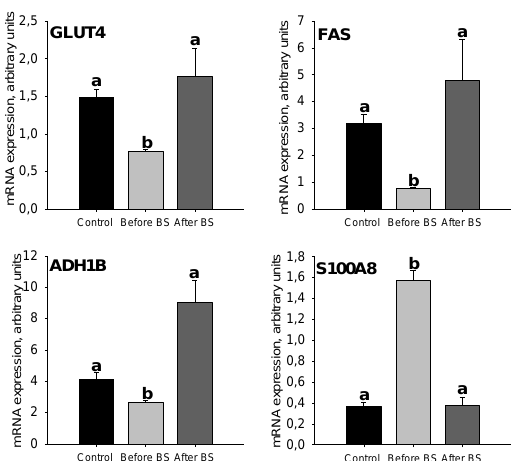
Figure 5. aSAT mRNA expression levels of GLUT4 , FAS , S100A8 and ADH1B in control patients and obese patients before BS and after BS and body weight normalization. Values are means ± SEM. Different letters above the bars indicate statistically significant differences, p < 0.05. Control = healthy patients with normal BMI, n = 27. Before BS, n = 145. After BS, n = 6. BS = bariatric surgery. J. Clin. Med. 2020 , 9 , x FOR PEER REVIEW S100A8 is a calcium- and zinc-binding protein that plays a prominent role in the regulation of inflammatory processes and immune responses including cardiovascular disease [34]. It is known that chronic low-grade inflammation of AT plays a crucial role in the pathophysiology of obesity [35] and increased expression of AT S100A8 can trigger macrophage mobility resulting in the progression of chronic inflammation in situ [36]. In the SWATH-MS analysis, the S100A8 protein showed a considerable decrease after weight loss induced by bariatric surgery. S100A8 mRNA expression levels (Figure 5) are increased during obesity, but weight loss restores the values observed in the control patients group. In the same way as the data shown in Table S4, this suggests that weight loss induced by BS improves inflammation in aSAT. The AT of insulin-resistant humans displays a lower expression of proteins involved in mitochondrial function. In turn, this leads to a lower availability of mitochondria-derived energy sources for lipogenesis in AT [31]. We also have to take into account that many of the proteins that were positively regulated after weight loss were related to mitochondrial cellular components (see Figure 3A) and moreover that they were part of the pathways related to the respiratory electron transport and ATP synthesis (see Table S2). Our next step was to study mitochondrial morphometrics. Mitochondria shape (aspect ratio), density and coverage are shown in Figure 6. An aspect ratio (AR) value of 1 indicates a perfect circle, and as mitochondria elongate and become more elliptical, the AR increases. Therefore, it seems that obesity leads to slightly more elongated mitochondria, something that is corrected after weight loss but not in a statistically significant way (Figure 6A). Density and coverage diminished with obesity and weight loss recovered these values, even at higher levels than those observed in the controls (Figure 6B,C).